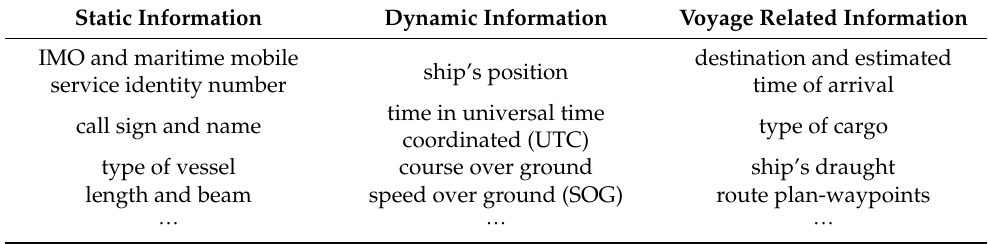
Table 1. Examples of information contained in the AIS data